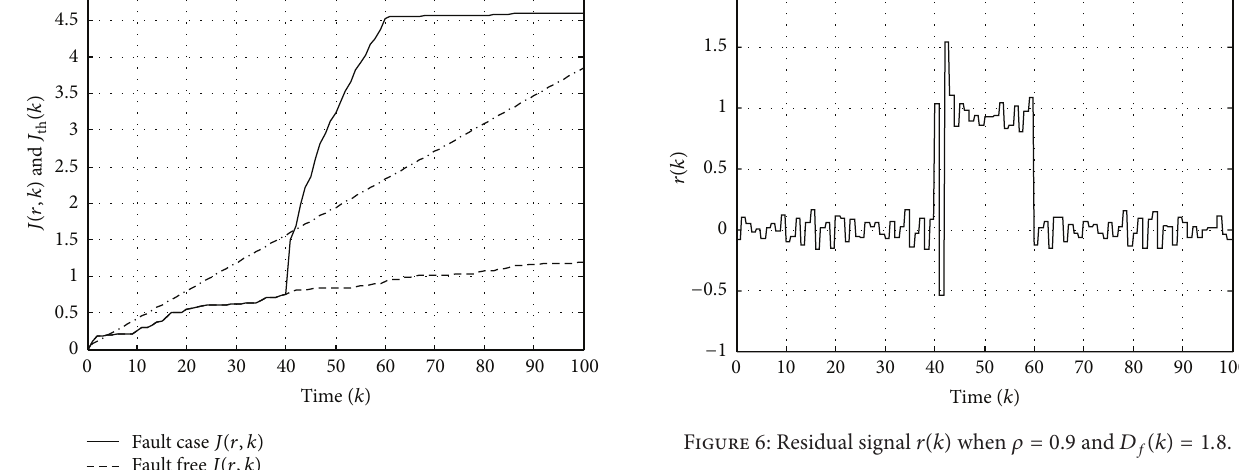
Figure 4: Residual evaluation function 𝐽(𝑟, 𝑘) and threshold 𝐽 when 𝜌 = 1 and 𝐷 𝑓 (𝑘) = 0 .